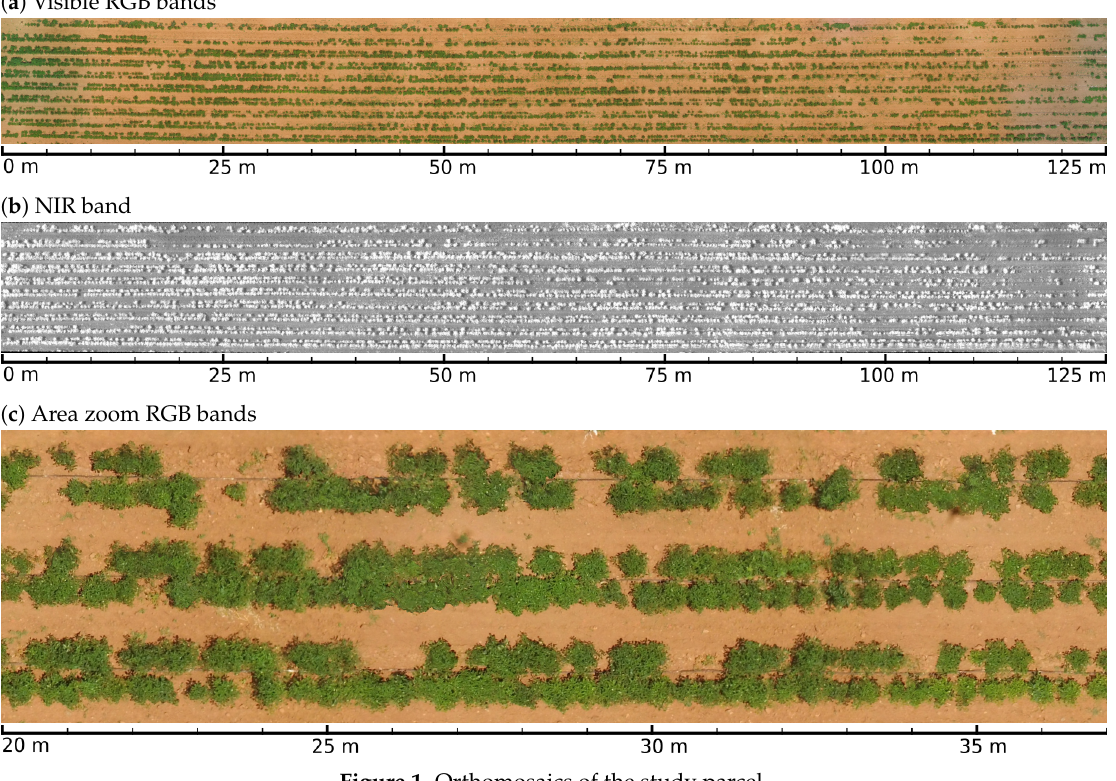
Figure 1. Orthomosaics of the study